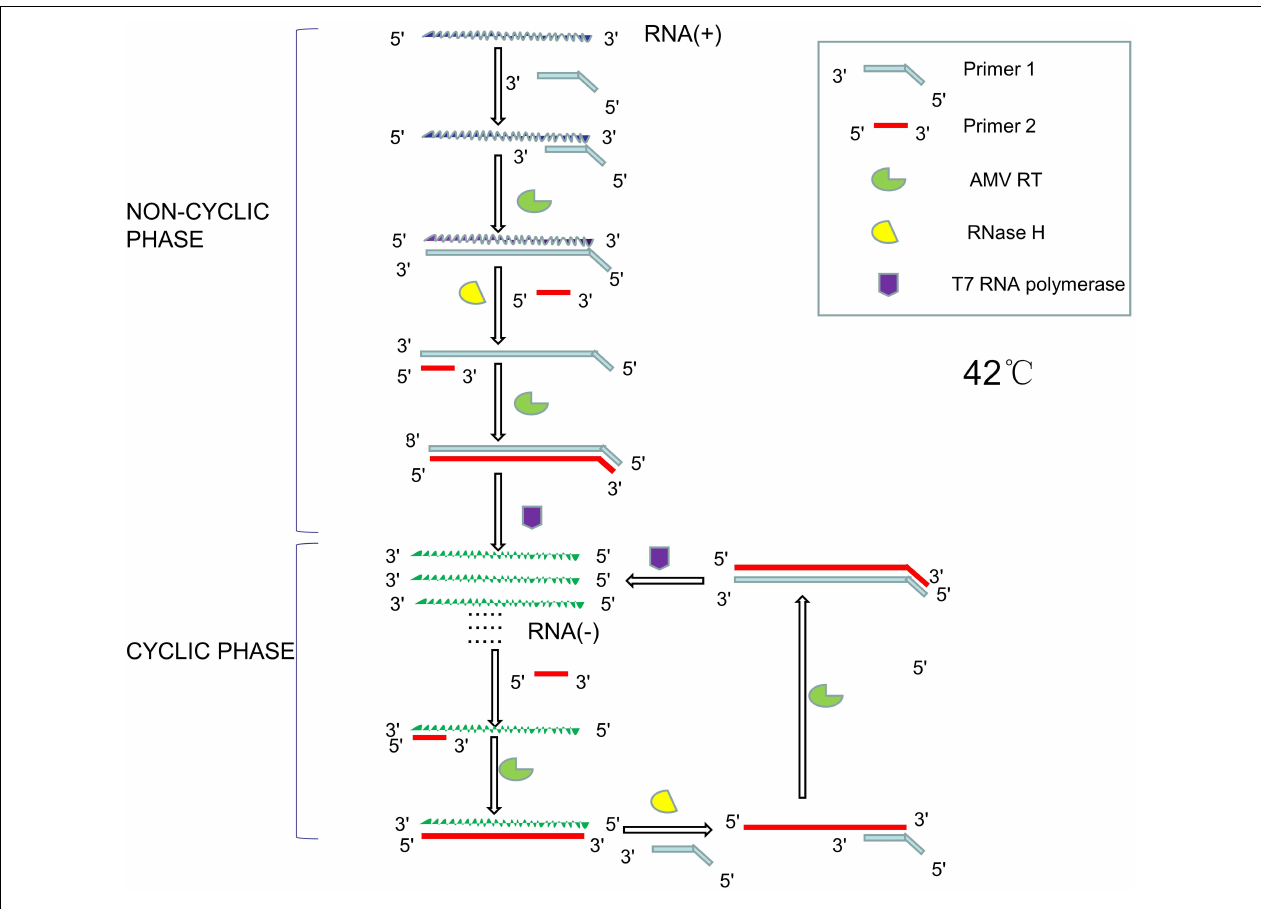
FIGURE 6 | Schematic diagram of NASBA